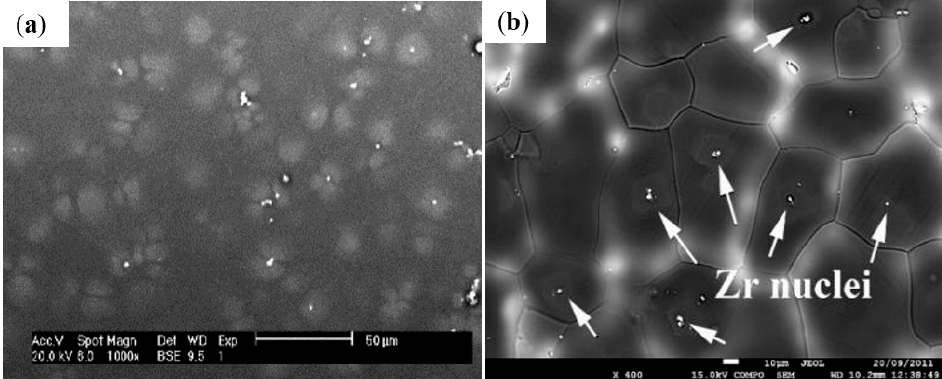
Figure 4. SEM BSE image of Zr-rich cores in: ( a ) Mg-0.56Zr alloy [37]; Reprinted with permission from ref. [37]. Copyright 2002 Elsevier. ( b ) Mg-5Gd-1.5Y-0.55Zr alloy [26]; Reprinted with permission from ref. [44]. Copyright 2013 Wiley.